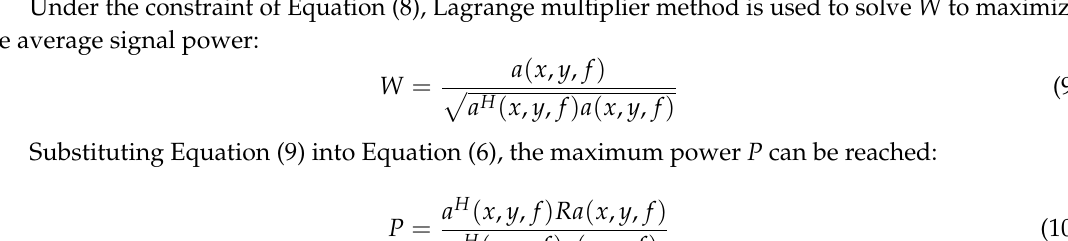
Figure 1. Schematic diagram of the near-field beamforming.